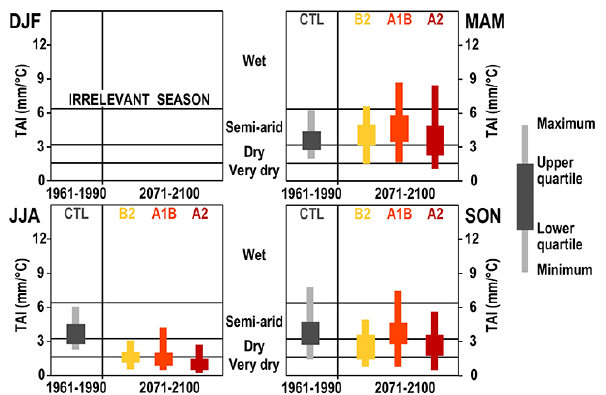
Fig. 3. Inter-annual variability of seasonal TAI time series in Hun- gary in the reference period (1961–1990) and the target period (2071–2100).